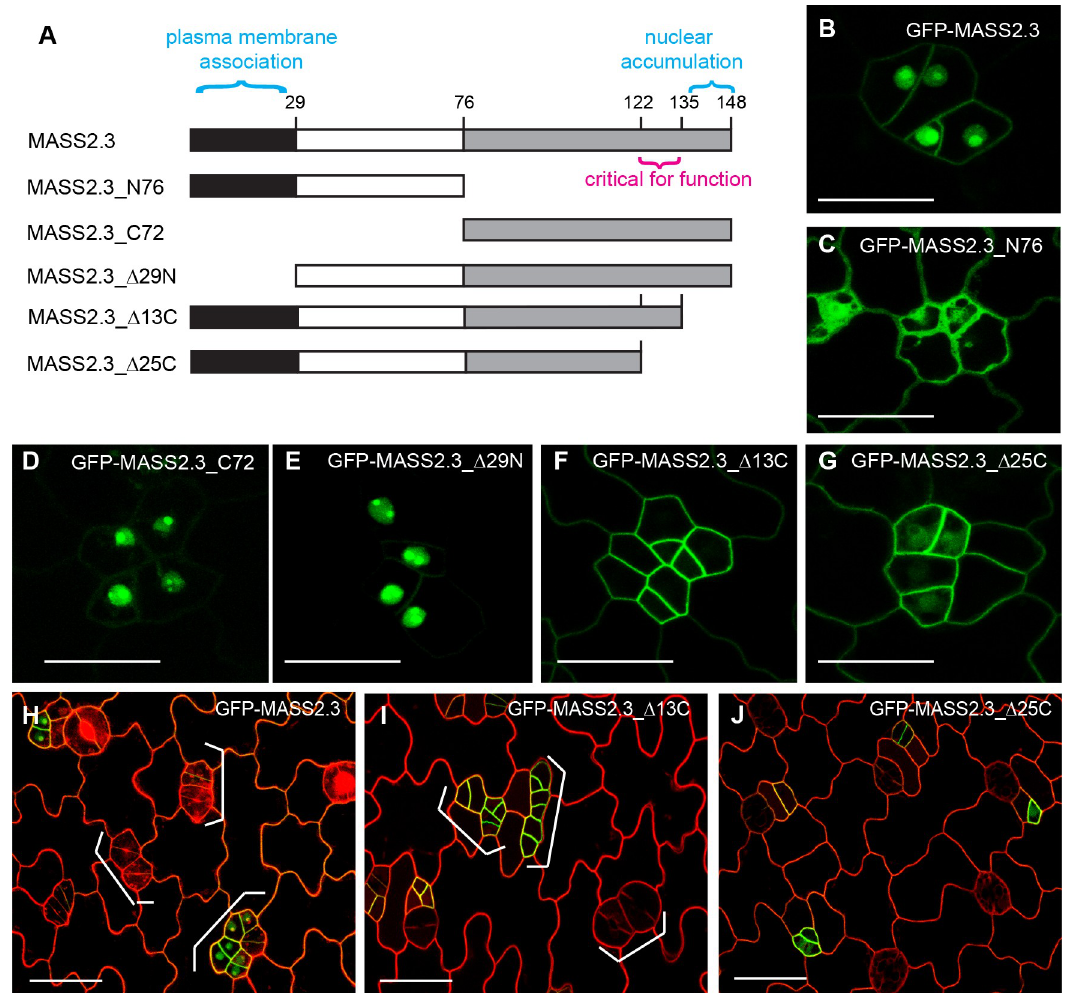
Fig 4. Fine-scale analysis of the MASS2 subdomains. (A) Diagram of MASS2.3 subdomains with proposed functions. N76, the N- terminal domain containing 76-aa; C72, the C-terminal domain containing 72-aa; Δ 29N, the N-terminal 29-aa deleted; Δ 13C, the C- terminal 13-aa delete; Δ 25C, the C-terminal 25-aa deleted. (B-G) Confocal images of 3-dpg adaxial cotyledon epidermis showing the localization of GFP-fused MASS2.3 variants (green). (H-J) Confocal images of 3-dpg adaxial cotyledon epidermis showing stomatal phenotypes of expressing GFP-MASS2.3 full-length and truncated versions (green). Brackets indicate stomatal clusters and abnormal cell divisions. Cell outlines in (H-J) were stained with PI. Scale bar represents 20 μ m in (B-G) and 50 μ m in